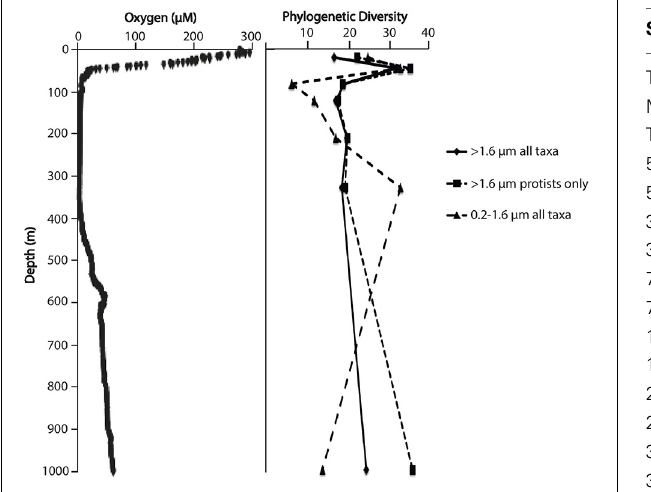
FIGURE 1 | Dissolved oxygen concentration and phylogenetic diversity as a function of water column depth. Diversity data points are mean values based on rarefaction of OTU counts at a standardized sequence count ( n = 1308 per sample).